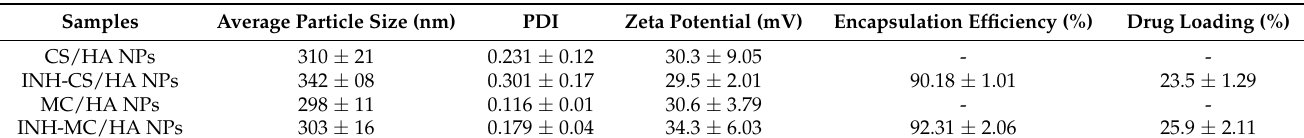
Table 2. Physicochemical attributes of nanopowders.